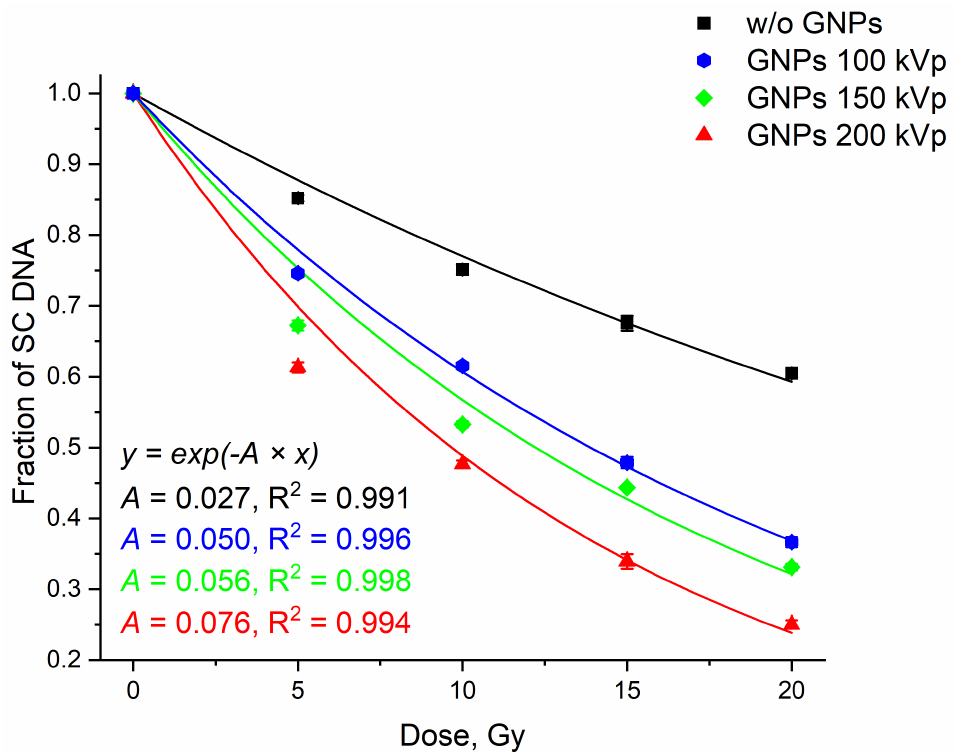
Figure 7. Dependencies of DNA damage on the irradiation dose at a di ff erent voltage on the X-ray tube: without GNPs (200 kVp, black) and in the presence of 2.4 mg / mL GNPs (d = 26 nm) at 100 kVp (blue), 150 kVp (green), and 200 kVp (red). The GNP:DNA ratio in the samples was 1.5 particles per one DNA molecule. Error bars are mean confidence intervals calculated by three parallel independent measurements for α = 0.05. Table 2. EF values for di ff erent voltages on the X-ray tube in the presence of 2.4 mg / mL of 26 nm GNPs. Dose, Gy